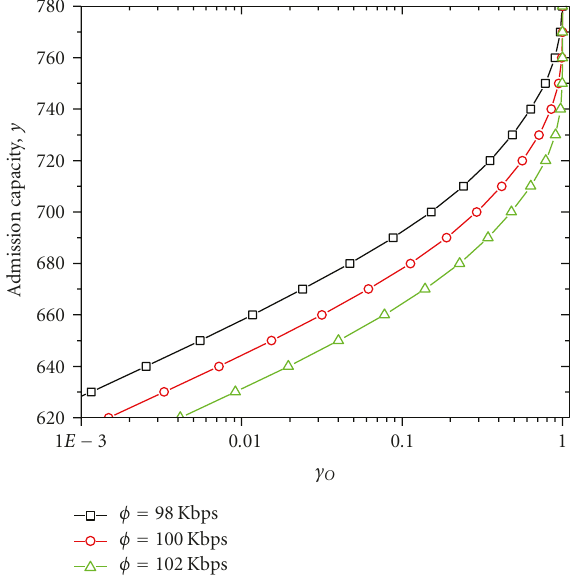
Figure 5: The maximum number of connections y versus γ O with = p = 50 mW, σ 2 = 10 − 11 , BER = 1 e − 5). respect to φ ( p s r